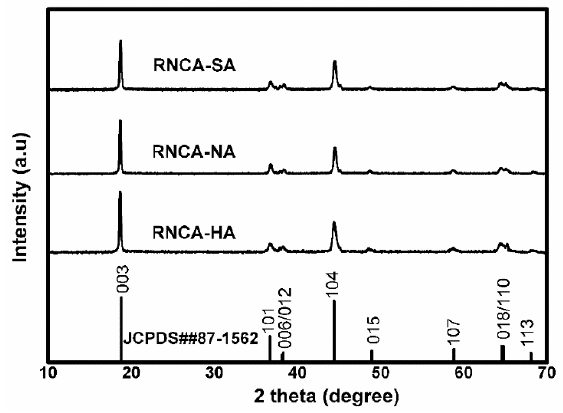
Figure 8. XRD patterns of RNCA using different leaching agents.